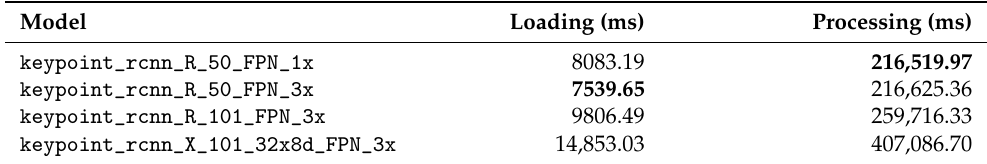
Table 2. Time comparison for COCO person keypoint detection baselines with keypoint R-CNN models, in milliseconds. The fastest result in each column is highlighted in boldface. Model Loading (ms) Processing